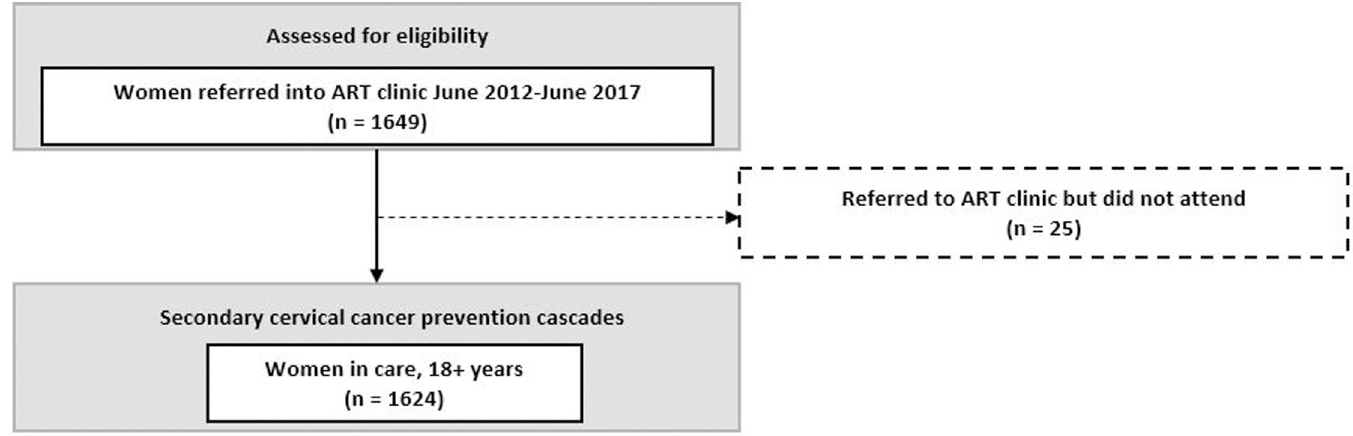
Fig 2. Flow diagram of women included in the analysis. ART; antiretroviral therapy, n; number of women.